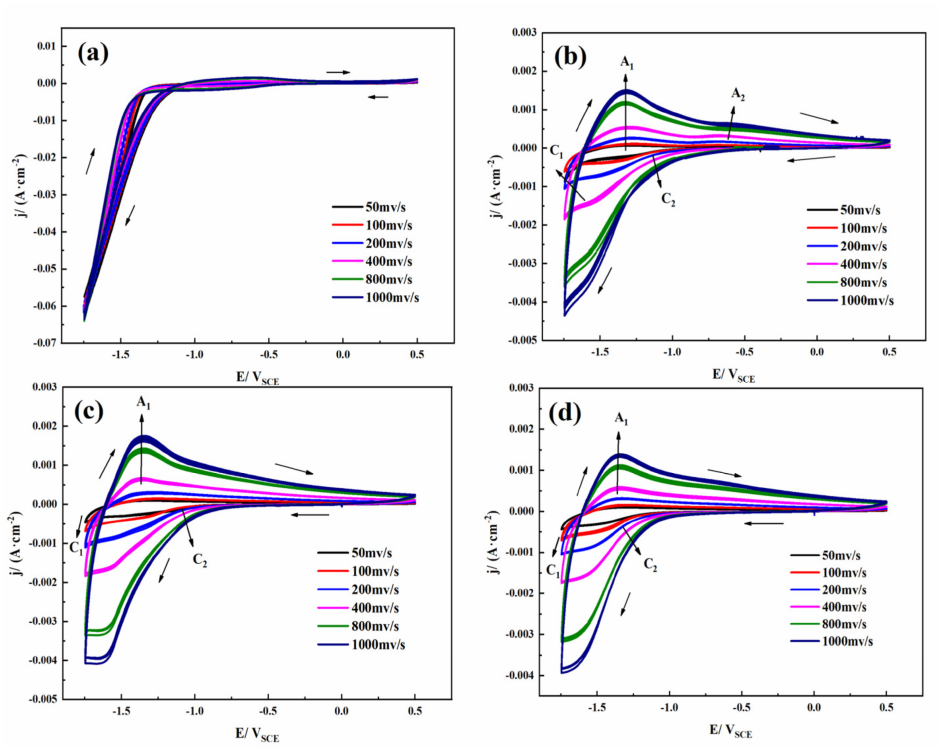
Figure 7. Cyclic voltammetry plots of TA2 in simulated seawater with different pH values using different scan rates: ( a ) pH = 1, ( b ) pH = 4, ( c ) pH = 7, and ( d ) pH =